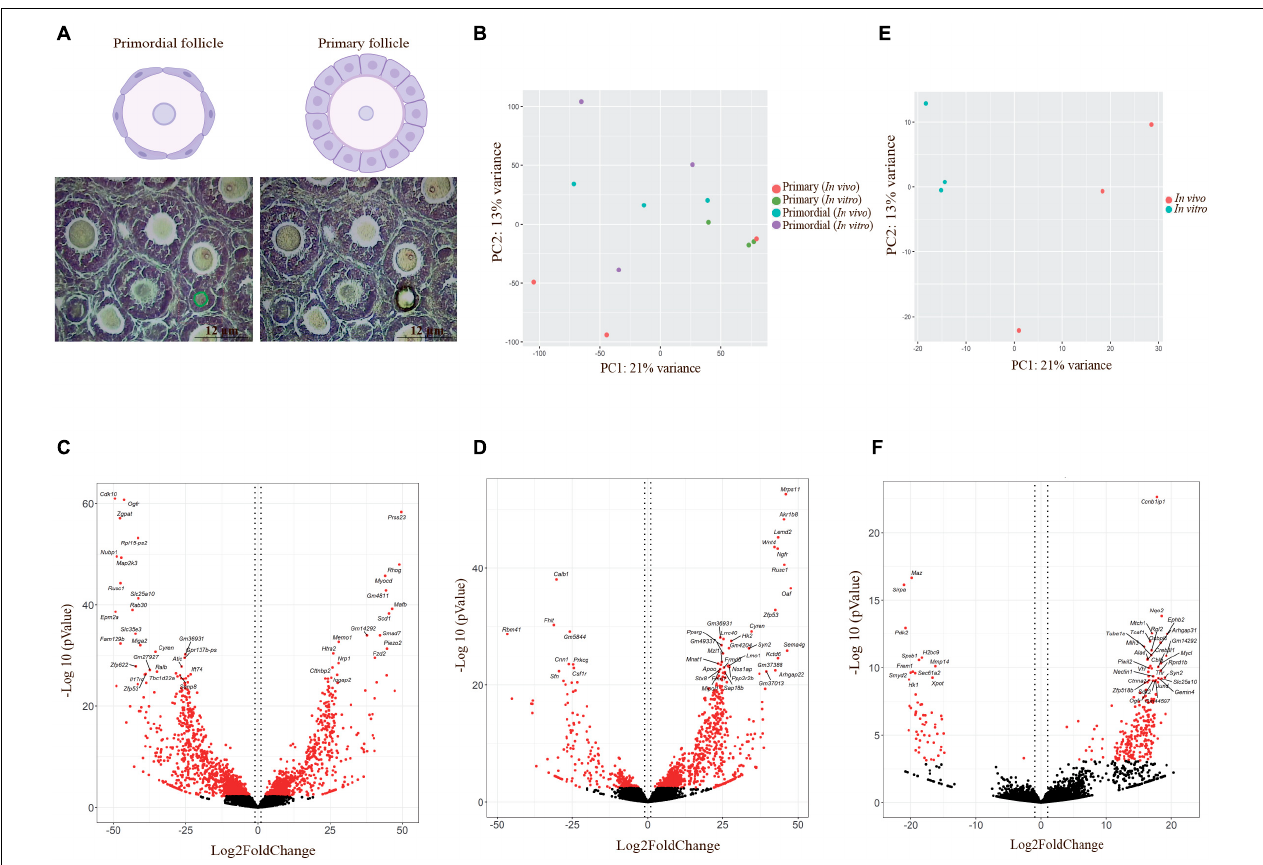
FIGURE 4 | Laser capture microdissection and differentially expressed gene (DEG) visualization. (A) Schematic images represent follicles in primordial and primary follicles. Primordial follicles are shown with flattened pregranulosa cells surrounding the oocyte, and primary follicles are shown with a single layer of cuboidal granulosa cells. Photomicrographs showing precise determination and cutting by laser capture microdissection based on defined classification of different developmental stages of follicles in the study. Scale bar: 12 µ m. (B) Principal component analysis (PCA) of DEGs in oocytes from primordial and primary follicles in the in vivo and in vitro groups, generated by R. Red and green dots show oocytes from primary follicles in the in vivo and in vitro groups, respectively. Blue and purple dots define oocytes from primordial follicles in the in vivo and in vitro groups, respectively. (C,D) Volcano plot of DEGs in oocytes from primordial (C) and primary follicles (D) in the in vitro group compared with the in vivo group. Vertical dotted lines indicate ± 1 log2 fold change. The 20 most significant genes are shown in volcano plots. Red dots indicate significantly expressed genes with adjusted p -values < 0.05, and black dots indicate non-significantly expressed genes. (E) PCA of DEGs in the in vivo- and in vitro -grown mature oocytes plotted using R. Red and blue dots represent in vivo- and in vitro -grown mature oocytes, respectively. (F) Volcano plot of DEGs in MII oocytes in the in vitro and in vivo groups. Vertical dotted lines indicate ± 1 log2 fold change. The 20 most significant genes are shown in volcano plots. Red dots indicate significantly expressed genes with adjusted p -values < 0.05, and black dots indicate non-significantly expressed genes.